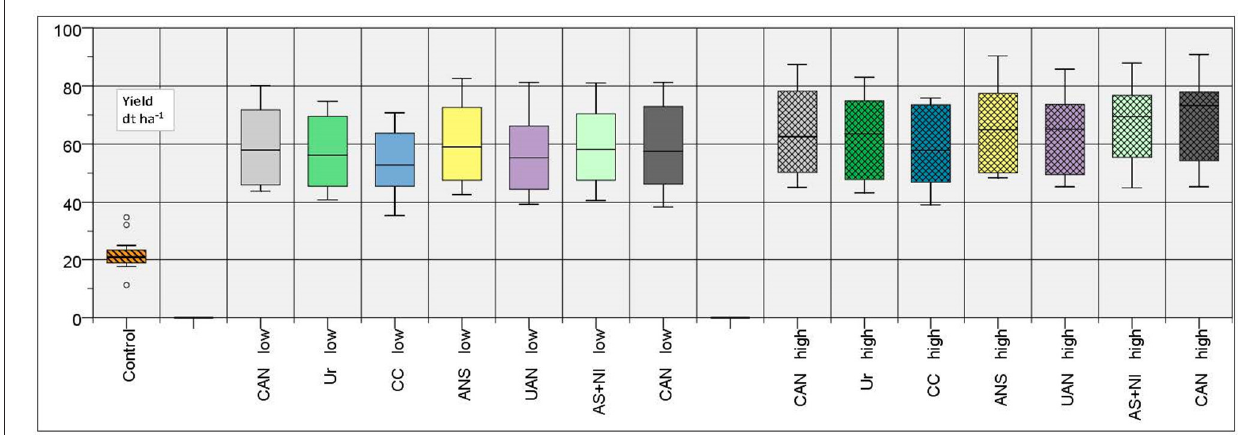
as mathematical functions of defined parameters (Geesing et al., 2014